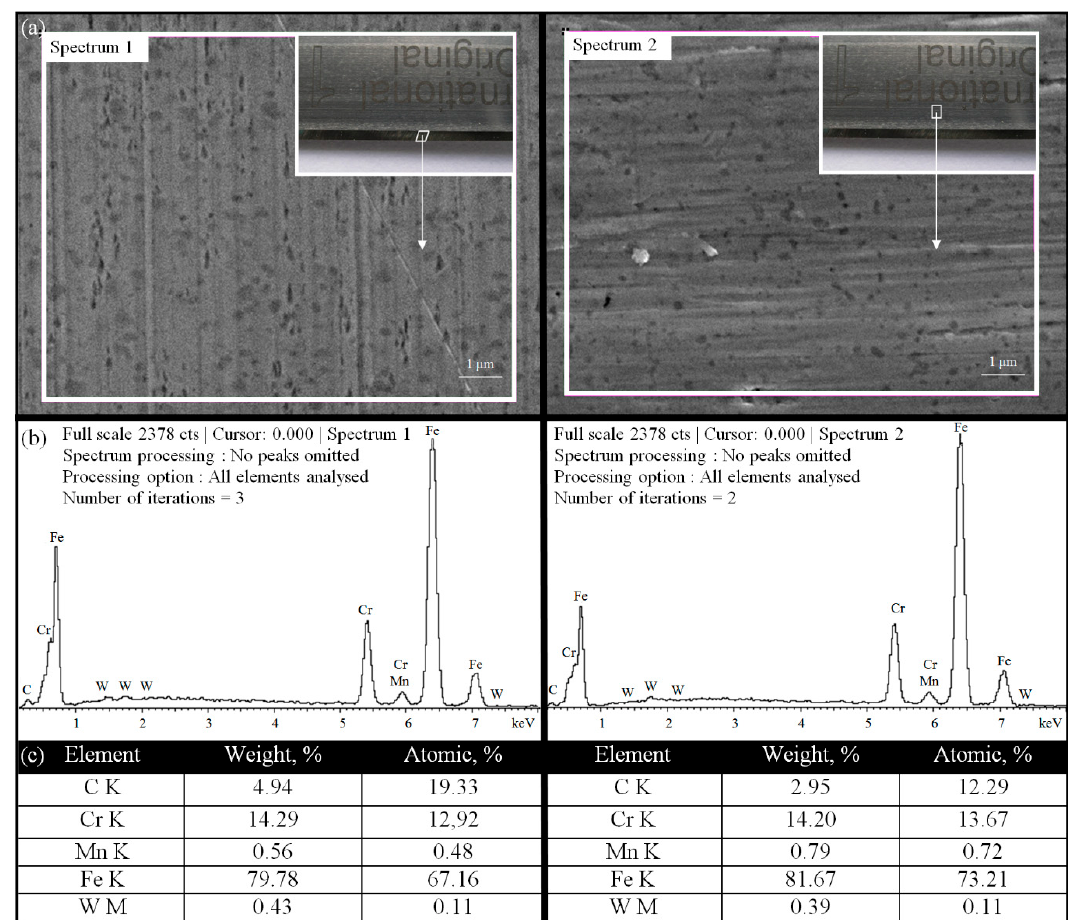
Figure 5. Energy-dispersive X-ray spectroscopy (EDS) quantitative microanalysis of the surface of the planar cutting blade (reference): ( a ) SEM micrograph of two selected areas (11.07 × 8.27 µ m) for which a microanalysis was carried out; ( b ) conditions of EDS microanalysis and EDS spectra obtained with identified elements contained in the analyzed areas; ( c ) calculated weight and atomic percentages of elements.